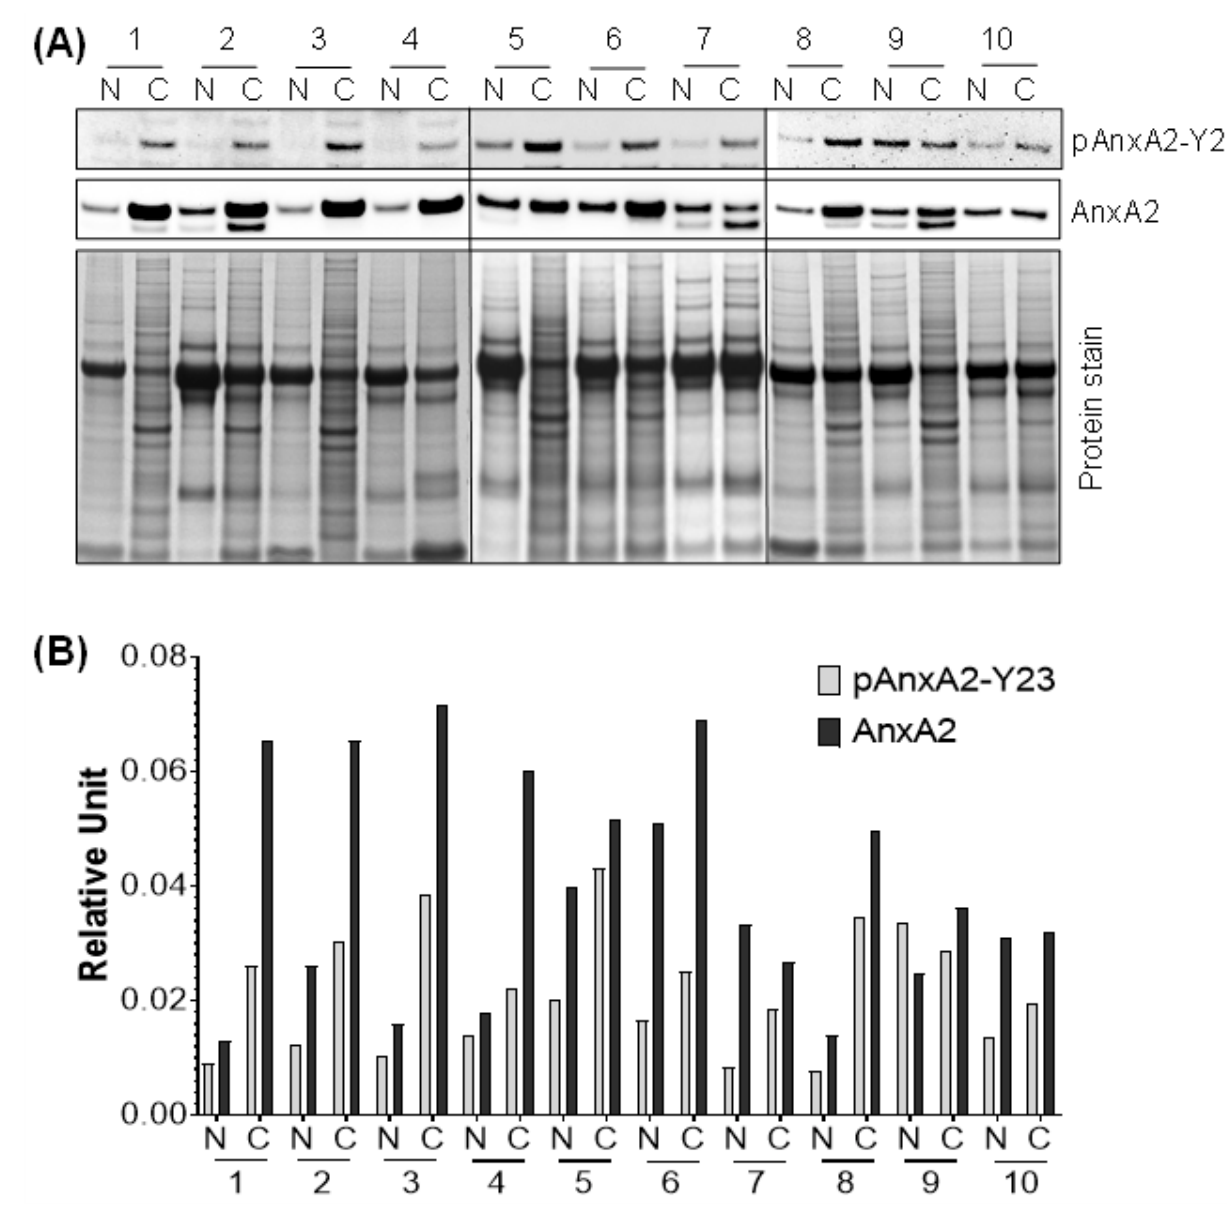
Figure 6. Expression of pAnxA2-Tyr23 and AnxA2 in tumor tissues of TNBC patients and matched adjacent non-tumorigenic breast tissues. ( A ) Immunoblot analysis of pAnxA2-Y23 and AnxA2 in tumor tissues of TNBC patients (C) and matching adjacent non-tumorous (N) breast tissues. Coomassie staining was used as a loading control. ( B ) Bar chart showing the densitometric analysis of pAnxA2-Y23 and AnxA2 bands of the immunoblot of panel A. Intensity of pAnxA2-Tyr23 and AnxA2 bands were normalized by total protein loading control. Uncropped Western Blots of ( A )are available in Figure S4.